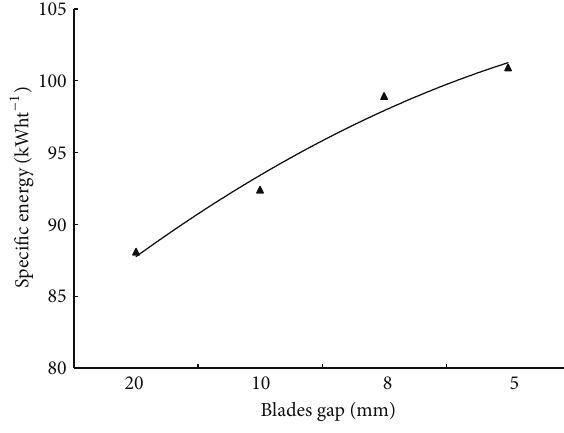
Figure 4: Effect on blades gap of advanced crusher on specific energy